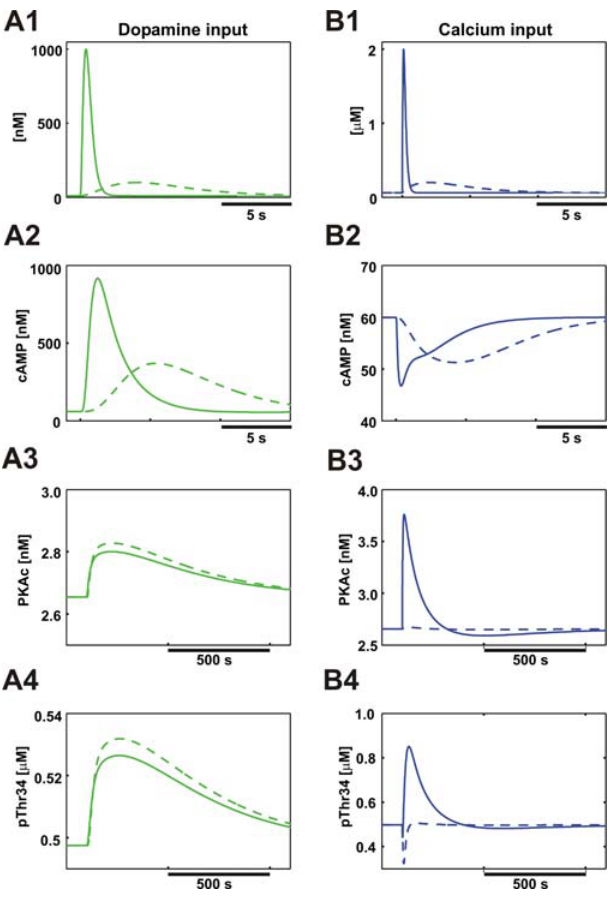
Figure 4. Responses to Transient Dopamine and Calcium Elevations (A1) A brief, high-amplitude (solid line), or slow, low-amplitude (dashed line) dopamine elevation, with approximately equal area under the curve, is used as input to the model network. Dopamine produces an elevation in cAMP (A2), an elevation in PKAc (A3), and an increase in phosphoThr34 (A4). While the cAMP signal follows the dynamics of the dopamine signal, PKAc formation and Thr34 phosphorylation are proportional to total amount of dopamine, as if integrating the cAMP signal because these reactions occur on a slower time scale. (B1) A fast (solid line) or slow (dashed line) transient calcium signal is used as input to the model. Calcium produces a decrease in cAMP (B2) due to both calcium-dependent activation of PDE1 as well as calcium- dependent inhibition of AC5. PDE1 has a larger effect on the maximal cAMP decrease, whereas AC5 has a larger effect on the later part of the cAMP reduction. Despite a decrease in cAMP, the free PKAc concen- tration (B3, solid line) is transiently increased following a fast and high calcium input, due to the calcium-dependent activation of PP2A, and causes an increase in phosphoThr34 (B4, solid line). A slower calcium input has minor effects on PKAc (B3, dashed line), but causes an initial decrease in phosphoThr34 (B4, dashed line), mostly due to a prolonged activation of PP2B. DOI: